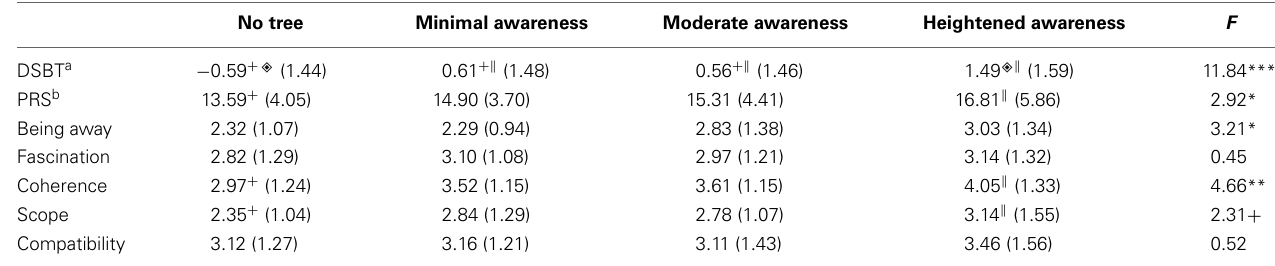
Table 2 | Cognitive performance of the four test